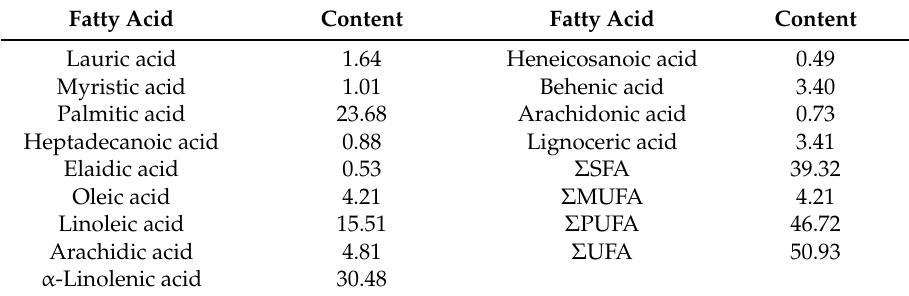
Table 2. Fatty acid compositions of the leaves and stems of Rubus coreanus Miquel. Fatty